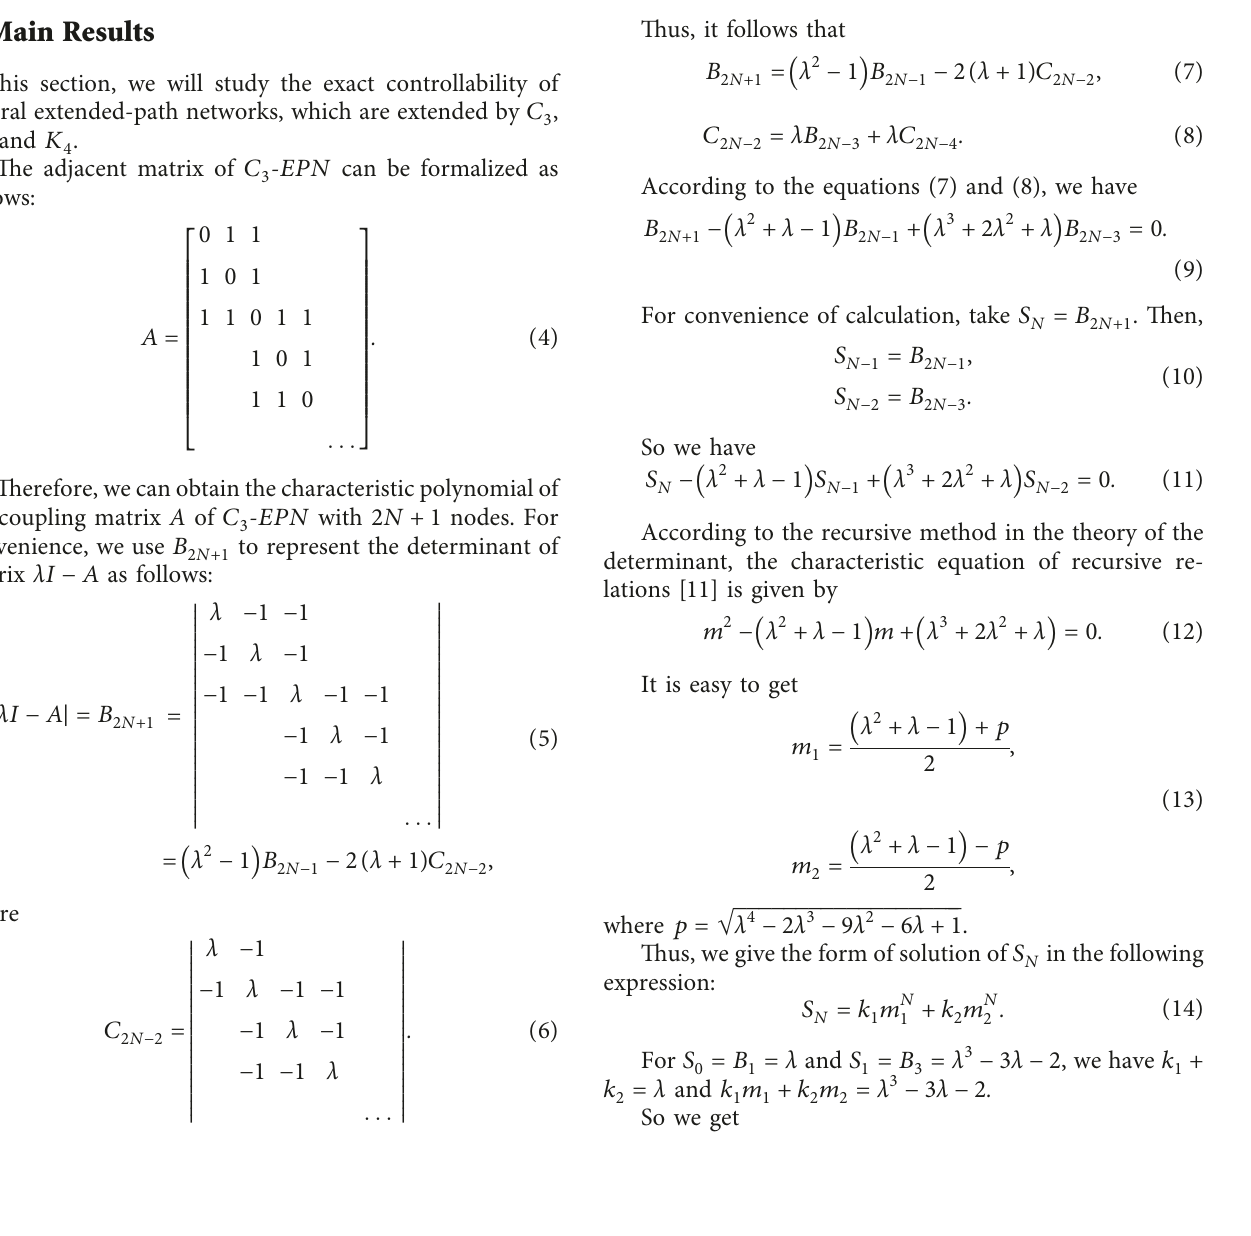
Figure 3: H - EPN extended by C